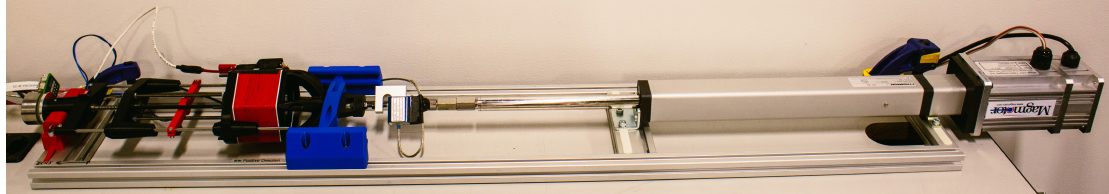
Figure A1. The custom universal testing machine (UTM) used for testing is depicted here with the DET VSA connected and the 200N load cell